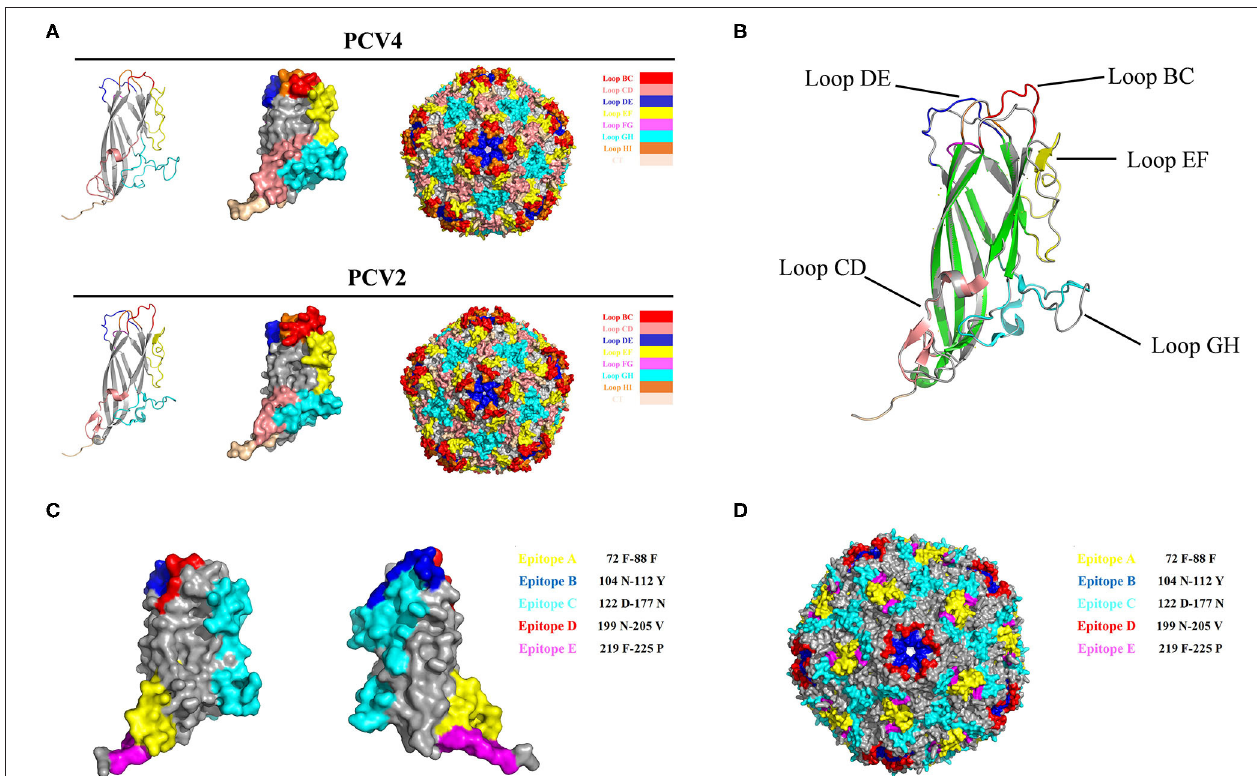
FIGURE 2 | (A) 3D structure of PCV Caps and capsid. 3D Structure of the PCV4 Cap was simulated via homology modeling using the PCV2 Cap as a template (PDB ID: 3R0R). Loops were labeled with various colors. (B) 3D structure alignment of PCV4 and PCV2 Cap. Prediction of immune-epitopes of the PCV4 Cap (C) and capsid (D) . The five predicted epitopes are indicated by various colors. (epitope A: yellow; epitope B: blue; epitope C: cyan; epitope D: red; and epitope E: magenta).